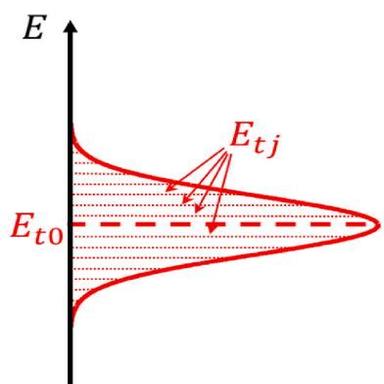
A discretized Gaussian trap distribution.